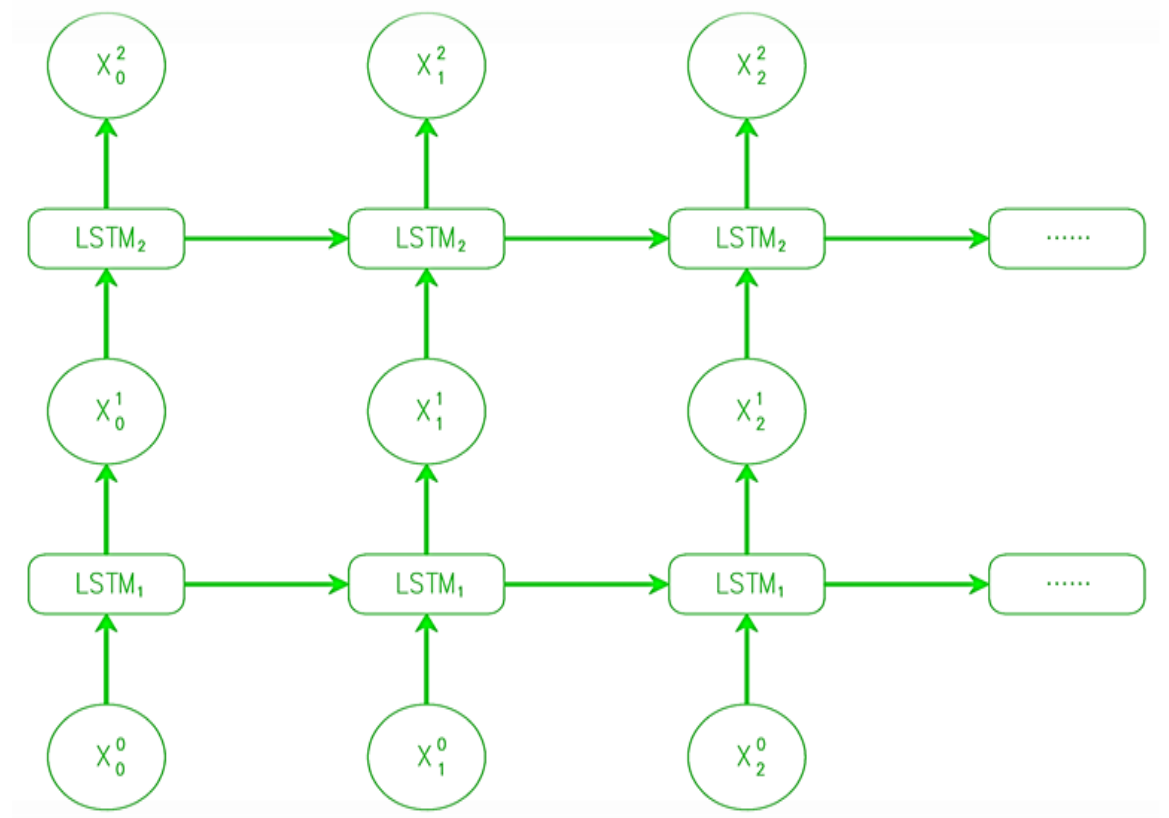
Figure 9. Basic architecture of the stacked LSTM model.